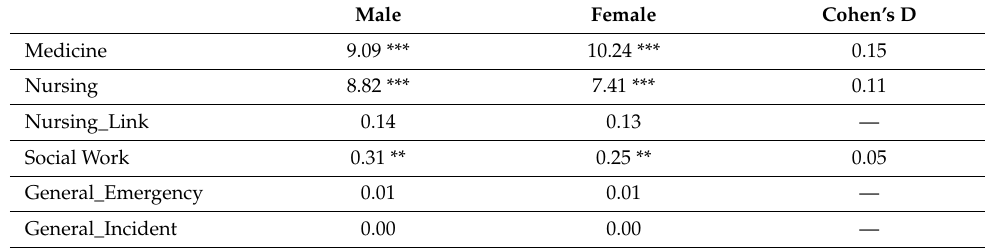
Table 6. Consultations made in primary care for persons over 65 years of age living alone based on the different specialties and sex. Basic Health Areas of Gran Canaria. 2018–2020. Averages.